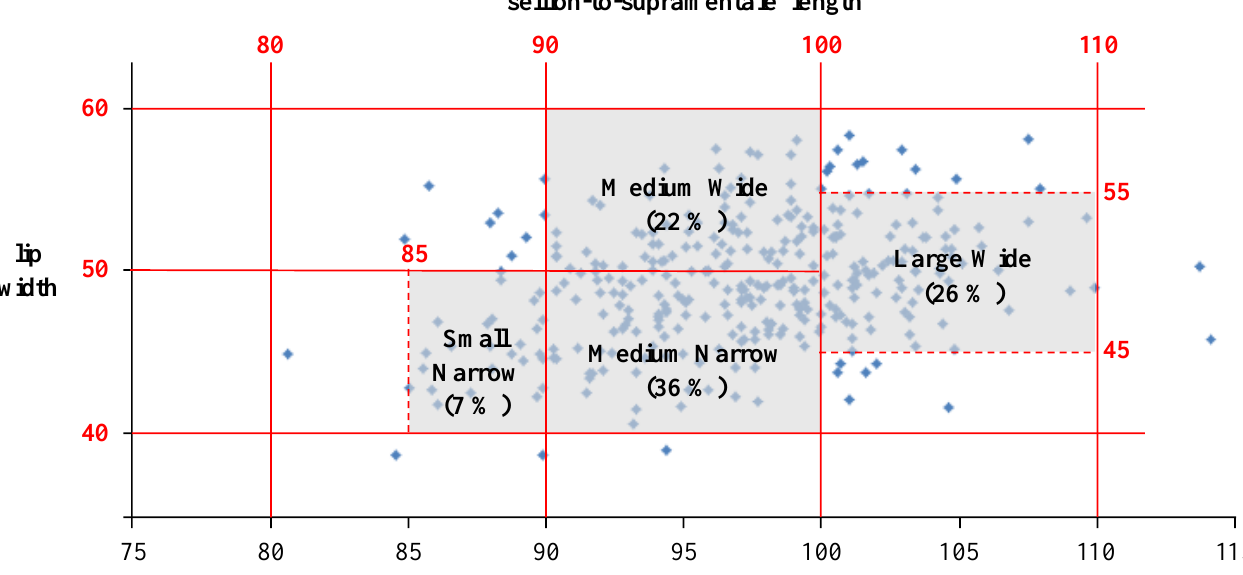
Figure 4. The final mask sizing system for KAF pilots with four sizing categories, updated by considering economic efficiency (accommodation percentage = 90%).